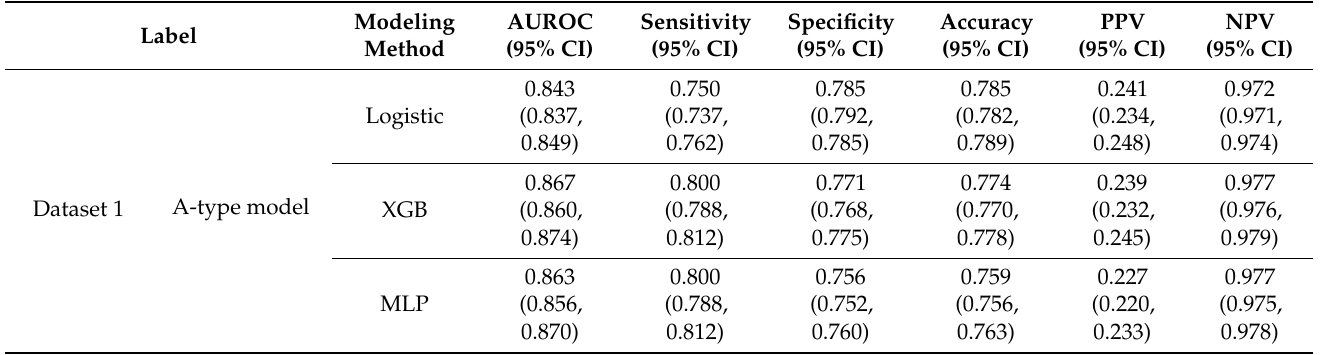
Table 1. Discrimination and test characteristics of acute myocardial infarction prediction models.